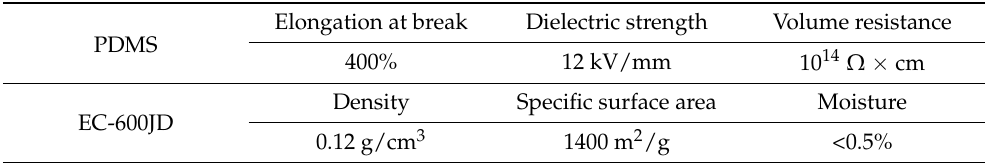
Table 3. Properties of the experimental materials.